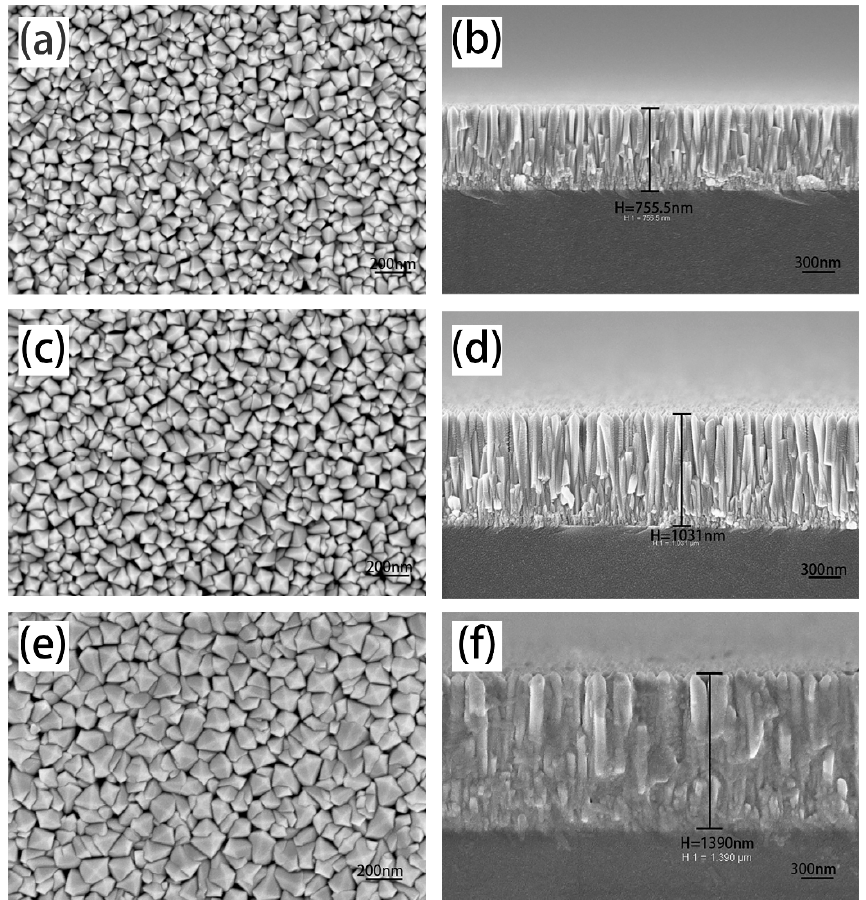
Figure 4. Surface and cross-section morphology images of multiple structure nanopillar crystalline films by SEM: ( a , b ) 150 W; ( c , d ) 200 W; ( e , f ) 250 W .